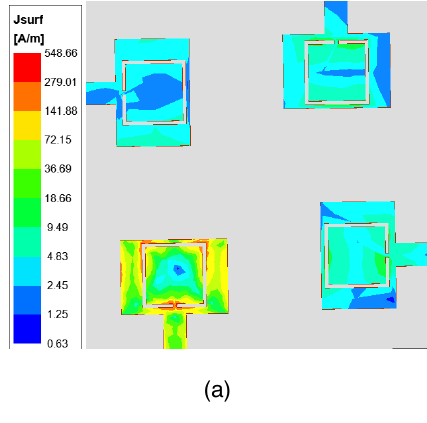
FIGURE 6. (a) Top view and (b) bottom view of the fabricated MIMO antenna.